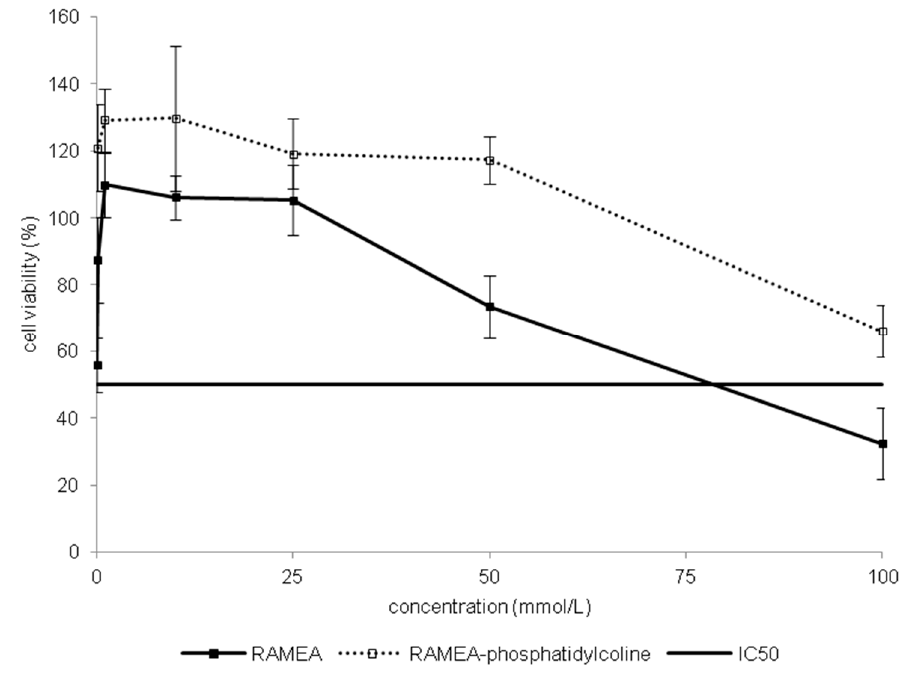
Figure 4. Comparison of toxicity on Caco-2 cells of RAMEA and RAMEA–phosphatidylcoline complex. Cell viability was expressed as the percentage of untreated control in the function of α -CD derivatives concentration. Values presented are means ± SD. All data were obtained from three to five independent biological replicates and in the same experiments four parallel concentrations were measured.